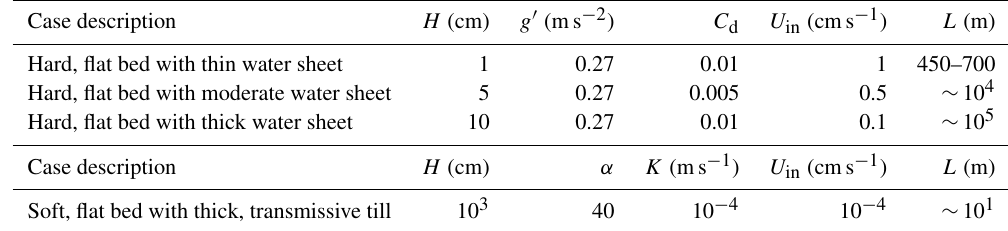
Table 1. Summary of predicted range of intrusion distances discussed in Sect. 3. Case description Hard, flat bed with moderate water